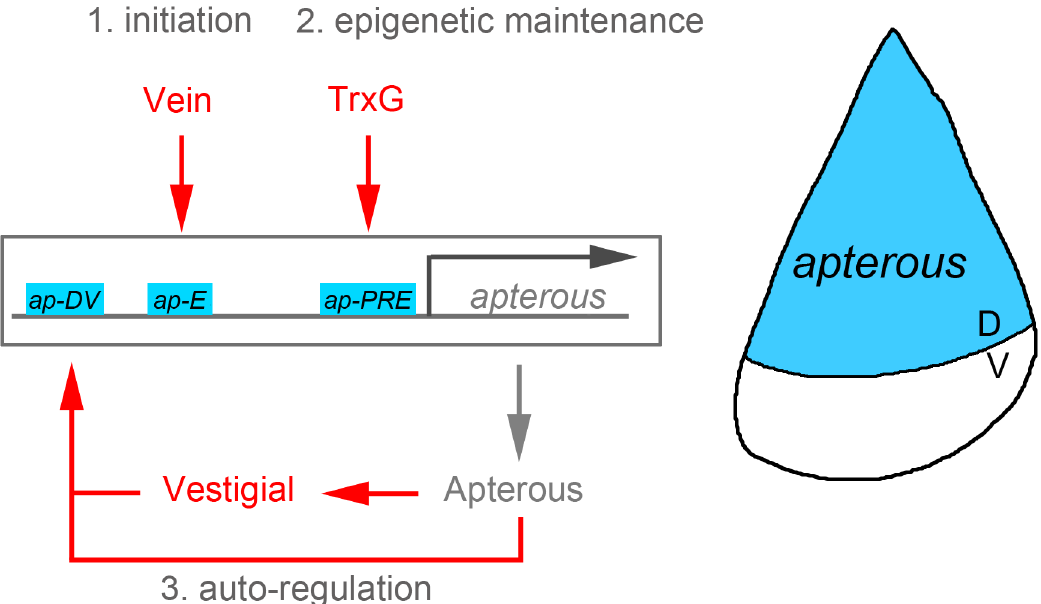
Fig 1. Illustration of the apterous locus with its regulatory regions involved in the control of its expression in the Drosophila wing. Whereas the onset of apterous expression in the dorsal compartment of the early wing primordium relies on the activity of the EGF receptor ligand Vein, the maintenance of its expression during subsequent developmental stages depends on both autoregulatory and epigenetic